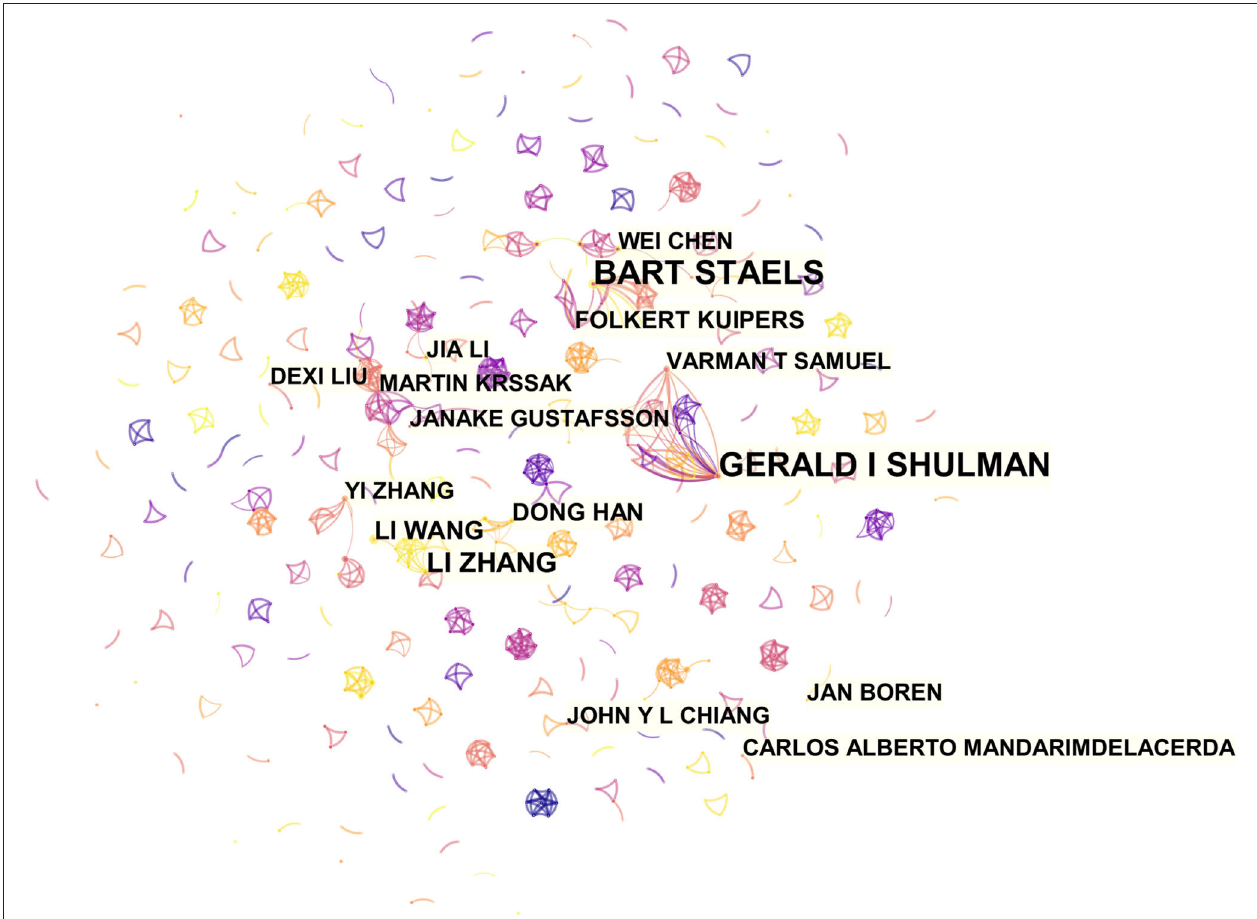
FIGURE 4 | CiteSpace network of authorship in the field of hepatic glycolipid metabolism research. The top 16 authors with the most publications are shown. Each circle represents an author, and a link between two circles means a collaboration between each other.